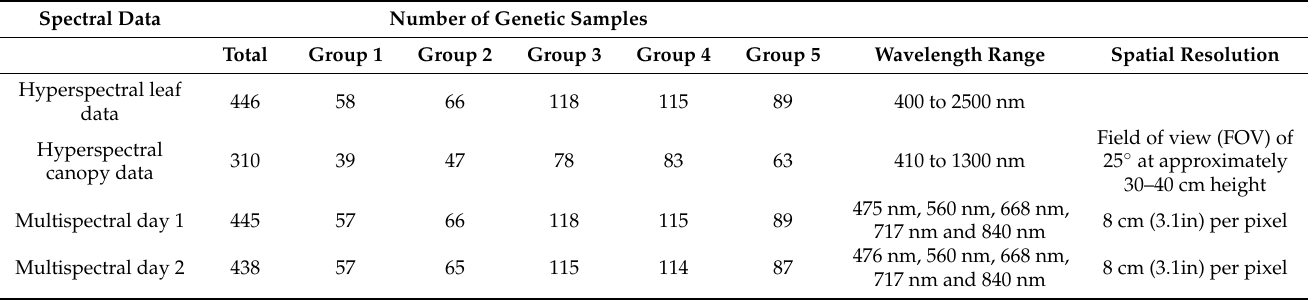
Table 1. Details of hyperspectral and multispectral data acquisition.